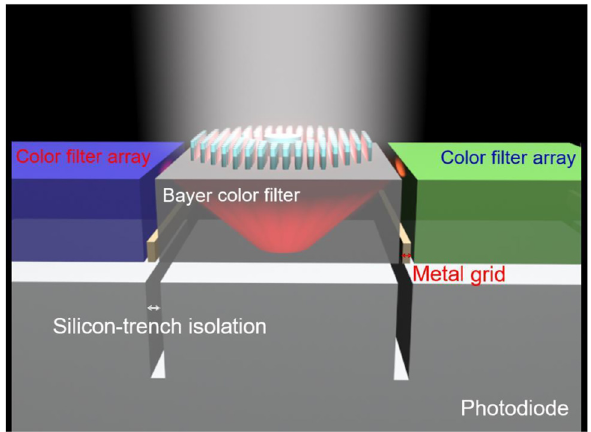
Figure 1: Schematic of the axicon metalens for CIS light harvesting. The pattern comprising a Bayer-type color filter. The axicon top layer is a TiO 2 metalens is surrounded with RGB bandpass